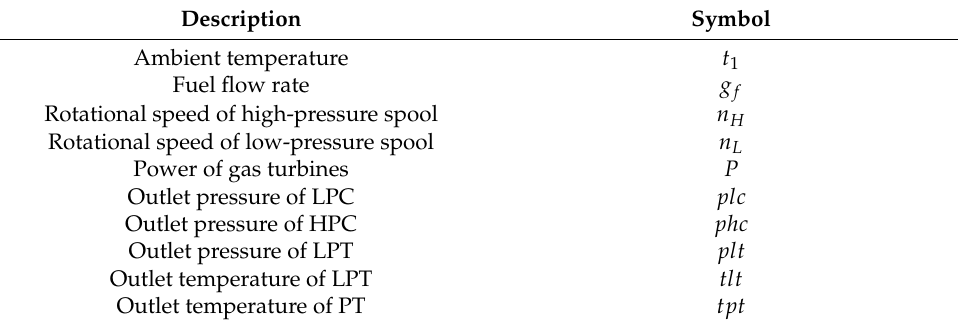
Table 1. Measurable